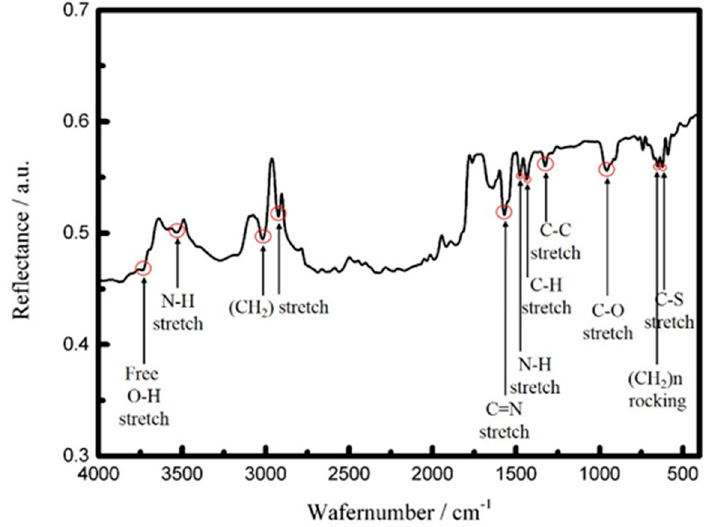
Figure 9. FT-IR spectrum of cystamine SAM/glutaraldehyde cross-linking layers.